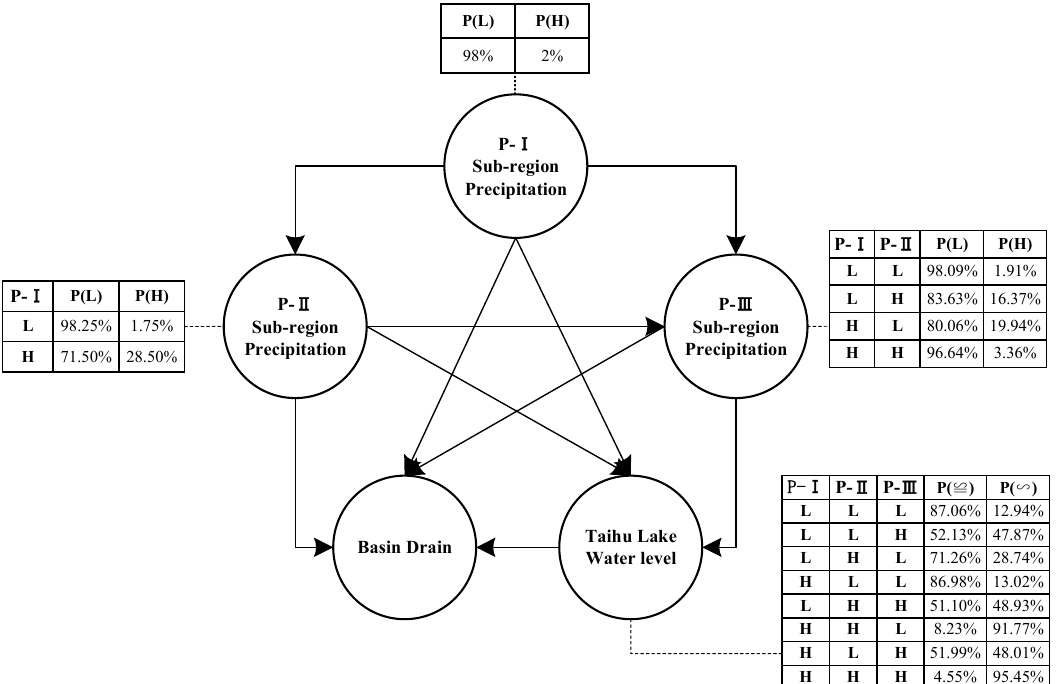
Figure 8. Bayesian network structure parameter map of the plum rain period.